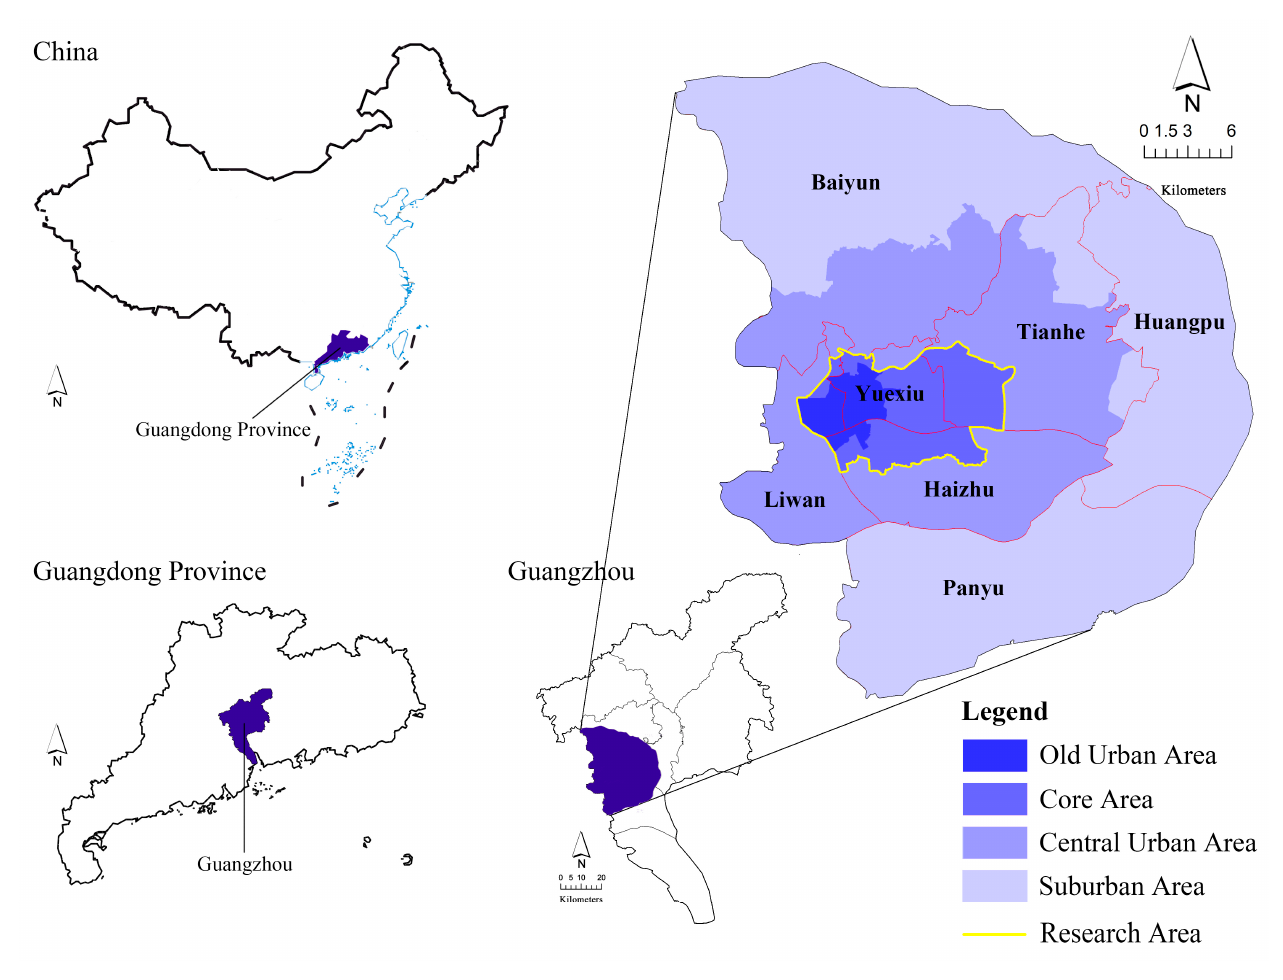
Figure 1. Map of the research area.